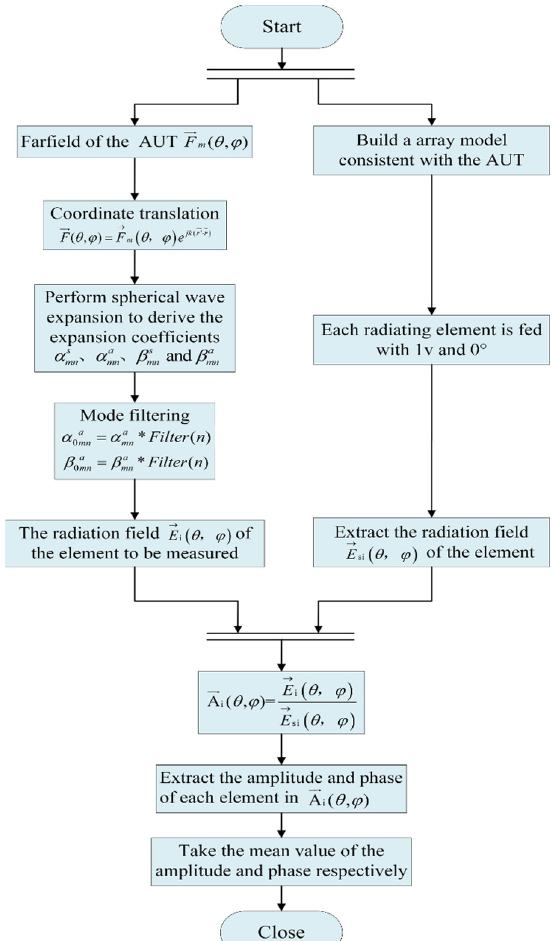
Figure 2. Flowchart of the SWEMF method.